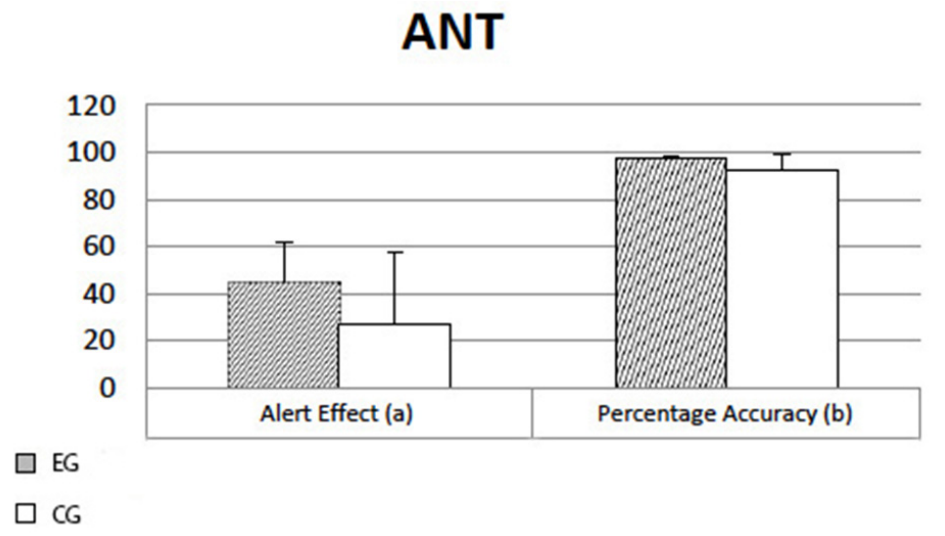
Figure 1. Results at the Attention Network Task (ANT): effects on Alert (panel a ) and Accuracy Percentage (panel b ).